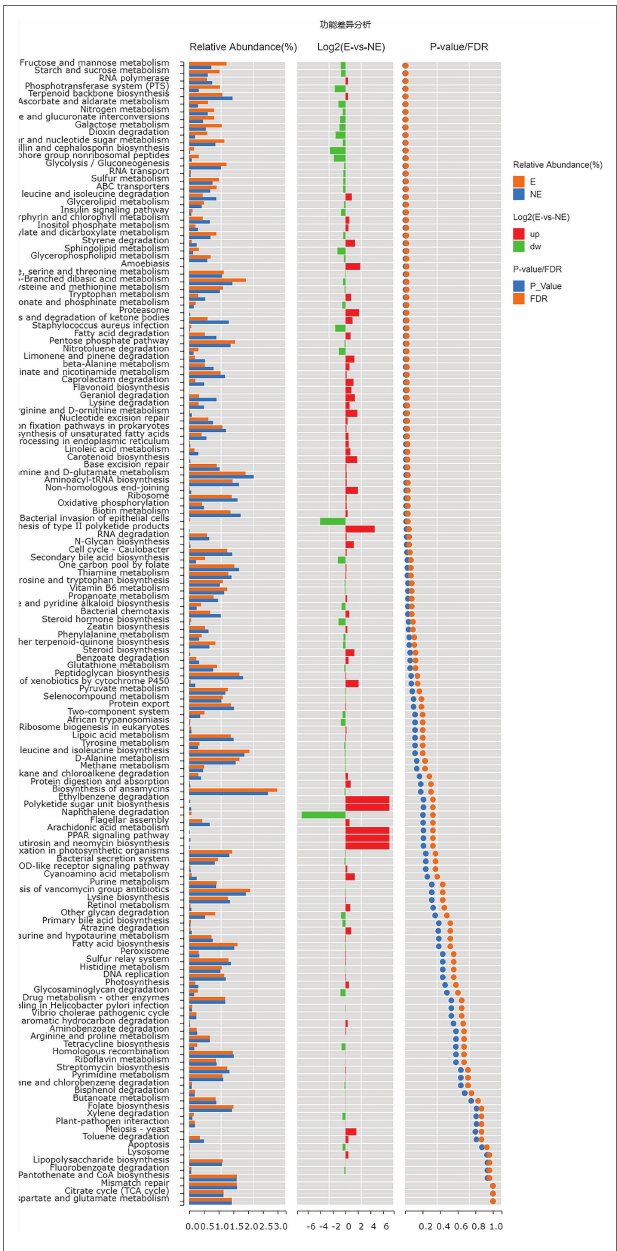
FIGURE 9 | Wilcox Test result map of pathway difference (KEGG level 3). The relative abundance bar chart of each group is shown on the left; the log2 value of the relative abundance mean ratio of the same pathway in the two groups is shown in the middle; and the value of p and FDR values obtained by wilcox test are shown on the right. If the value of p and FDR values are less than 0.05, the pathway is significantly different between the two